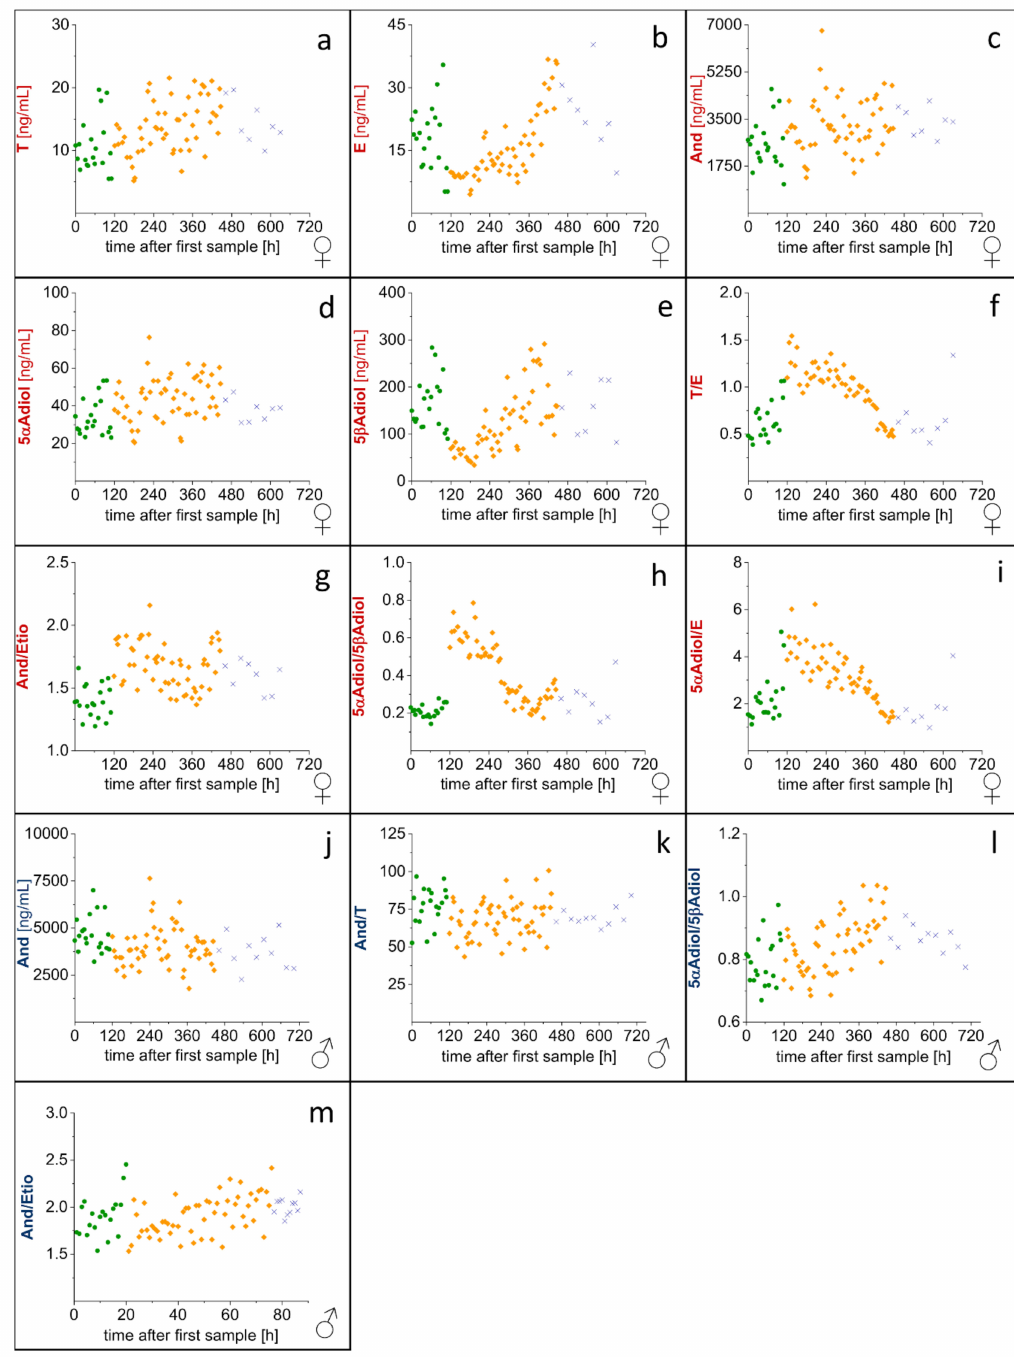
Figure 6. Time course of steroid profile markers which changed significantly over time; ( a – i ): female volunteer; ( j – m ): male